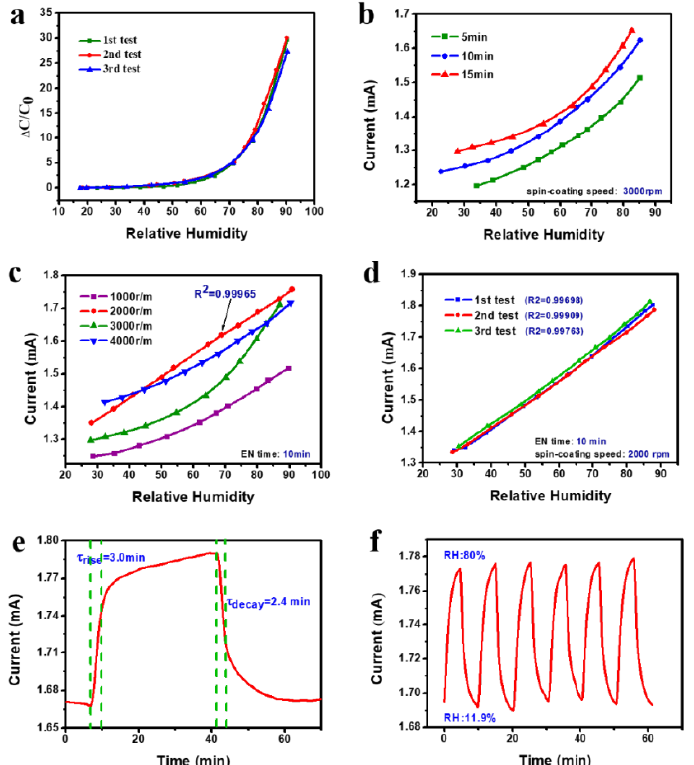
Figure 4. ( a ) Capacitance response to relative humidity in three different measurements with the relative humidity range from 20% to 90%. ( b ) Alternating current behavior of the device with different EN time of bottom electrode-Ni under different humidity levels. ( c ) 𝐼~𝑅𝐻 curves of paper-based ACELs with different spin-coating speed of phosphor layer. ( d ) Current response to relative humidity in three different measurements. ( e ) Current-time curve of the device from 11.9% to 80% RH estimating response and recovery time. ( f ) Cycling stability of paper-based ACEL from 11.9 – 80% RH level.